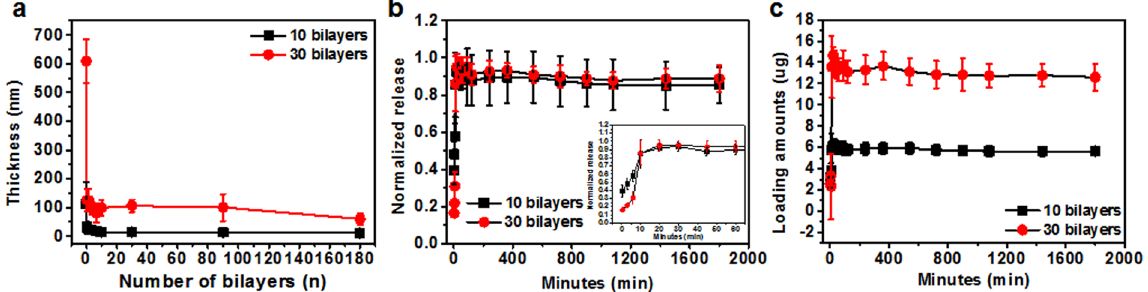
Figure 3. ( a ) Decreasing film thickness of printed (PLL/HA/FITC) n(n = number of trilayers) trilayer-based nanofilms over time. ( b ) Normalized and ( c ) total release profiles of printed (PLL/HA/FITC) 10, 30 nanofilms during 30 h.